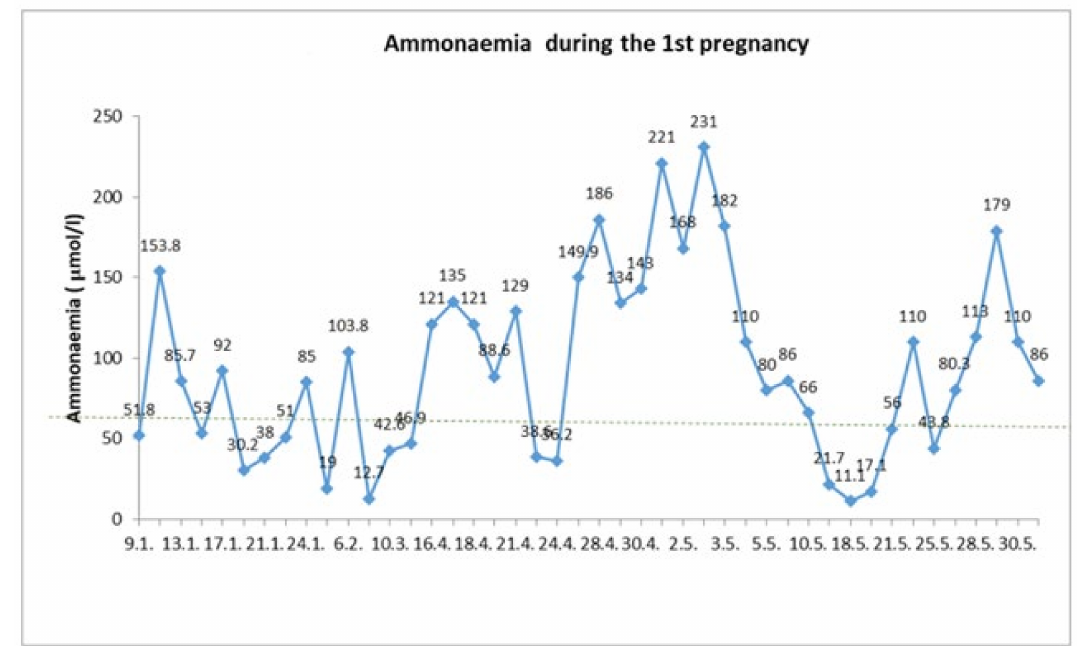
Figure 1. The course of ammonemia during the first pregnancy. The patient was hospitalized in multiple specialized clinical settings from 16 April until 1 June 2015. Despite the high-energy intake managed by the administration of 20 and 40% glucose infusions and intravenous arginine and sodium-benzoate, the effort to reduce ammonia levels to the normal values (below 60 µ mol/L) did not succeed for an extended time. Signs of impaired consciousness on May 2nd and an ammonia level rise to 231 µ mol/L resulted in the reinitiation of sodium-phenylbutyrate treatment, which had a transient positive effect on the plasma ammonia level. Despite an unchanged treatment, on May 29th, the ammonia level rose to 179 µ mol/L again and the patient reported transient weak fetal movements. Initiation of corticosteroid fetal lung maturation was indicated and on 1 June delivery by C-section was performed due to the potential risk for the mother and her